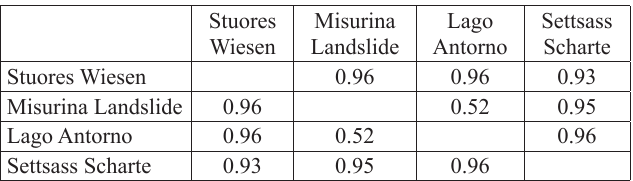
Fig. 33. Rarefaction curves of Cassian assemblages from Misurina Landslide, Lago Antorno (assemblages studied herein), Settsass Scharte (Nützel and Kaim 2014) and Stuores Wiesen (Hausmann and Nützel 2015). Only bulk samples Table 5. Dissimilarity (using mean proportional dissimilarity) between Cassian assemblages from Misurina Landslide, Lago Antorno, Stuores Wiesen (Hausmann and Nützel 2015) and Settsass Scharte (Nützel and Kaim 2014). Only bulk samples were used.